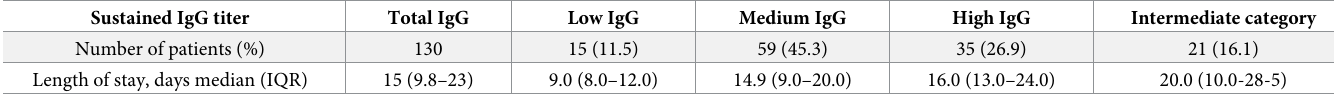
Table 2. Length of hospitalization is associated with sustained IgG titer against SARS-CoV-2 spike protein. 130 patients out of 147 (patients with less than 7 days of hospitalization were excluded) were categorized into three separate categories ( < 25 th , 25 th -75 th and > 75 th percentiles of all EC 50 values) according to their corresponding sustained IgG response, which was maintained for at least 5 consecutive days during hospitalization. Out of the 130 patients, 21 patients with IgG titer fluctuating between the three established categories were separated into an intermediate category. Kruskal-Wallis test shows a significant association between the LOS and sustained IgG cate- gories (p value = 1.2x10 -3